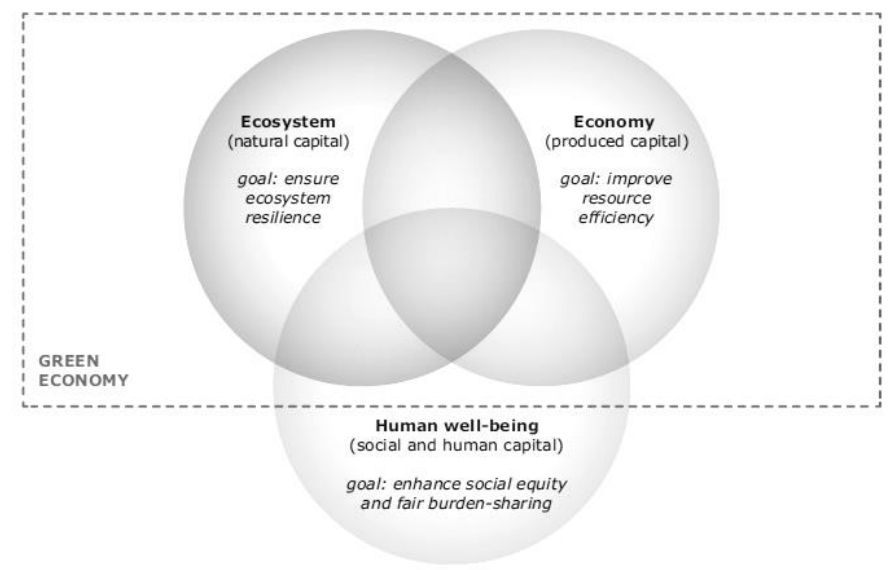
Fig. 1. The ‘green economy concept’ in the context of sustainable development (Martin & Henrichs,